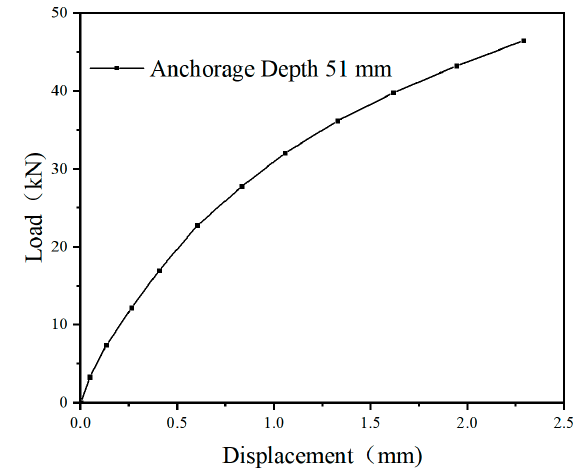
Figure 24. Load–displacement curve of wall panel with an anchorage depth of 51 mm of the con- nector.